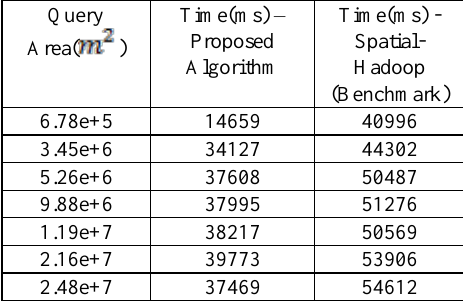
Table 1. The query time vs. query area